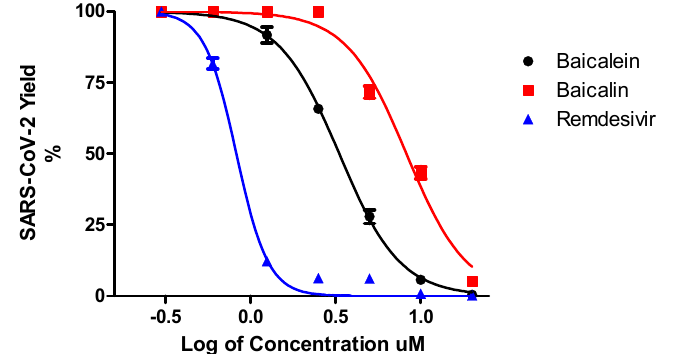
Figure 2. Dose-dependent antiviral study. Antiviral activity of baicalein and baicalin and remdesivir against SARS-CoV-2 in Vero cells was measured in a dose-dependent manner. SARS-CoV-2 Yield (%) was calculated based on the viral RNA copy number for each sample compared to untreated-infected control.